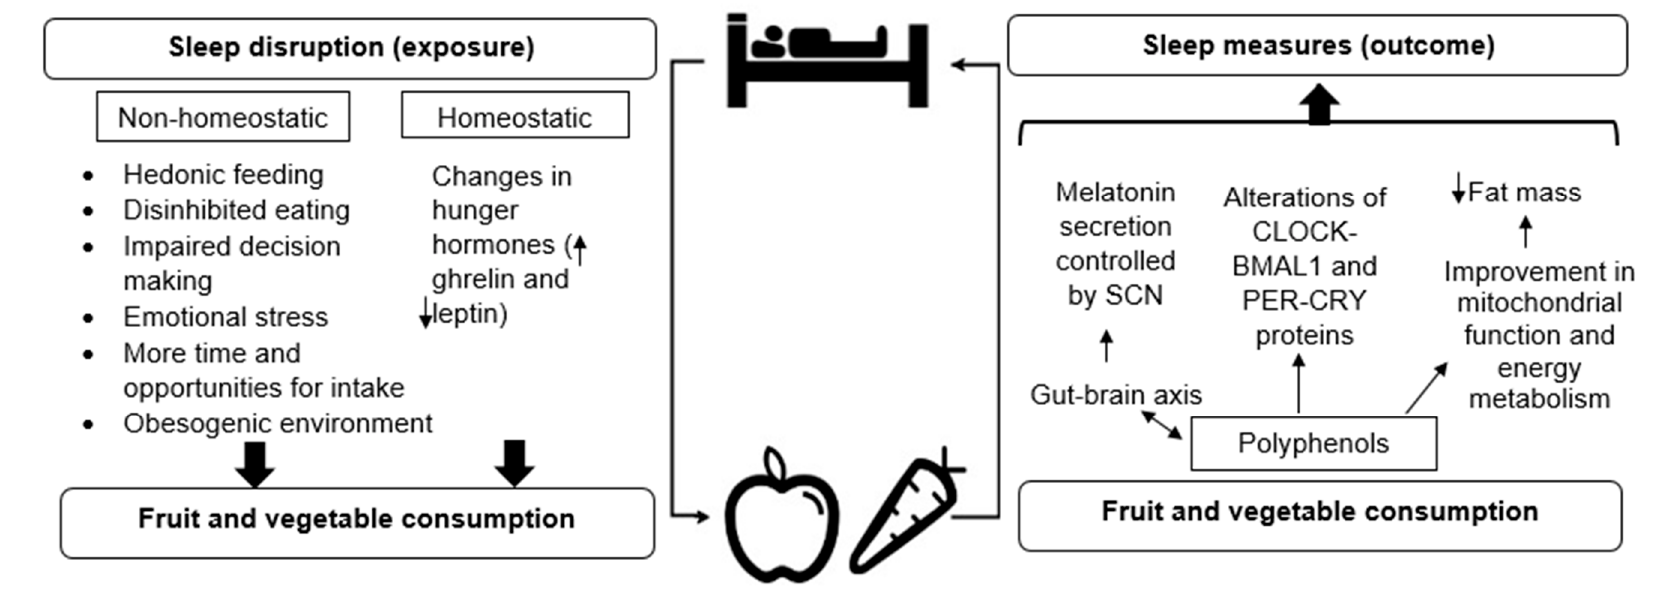
Figure 1. Potential reciprocal mechanisms between sleep duration and fruit and vegetable consumption. Sleep disruption may influence dietary intake through non-homeostatic and homeostatic mechanisms. On the other hand, FV consumption may influence sleep through their polyphenol content through several potential pathways. With further research, other potential mechanisms may be identified. Legend: SCN (suprachiasmatic nuclei); CLOCK (circadian locomotor output cycles kaput); BMAL1 (brain and muscle aryl hydrocarbon receptor nuclear translocator-like 1); PER (period); CRY